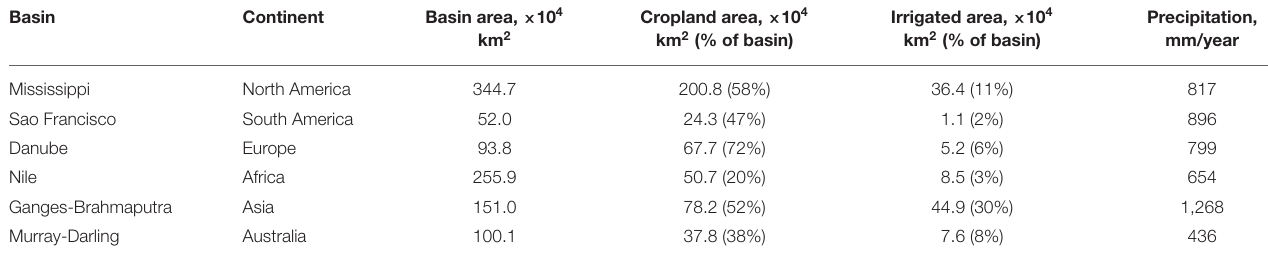
TABLE 1 | Study basins with respective continents, basin area, cropland area, irrigated area, and average (2003–2019) annual precipitation.